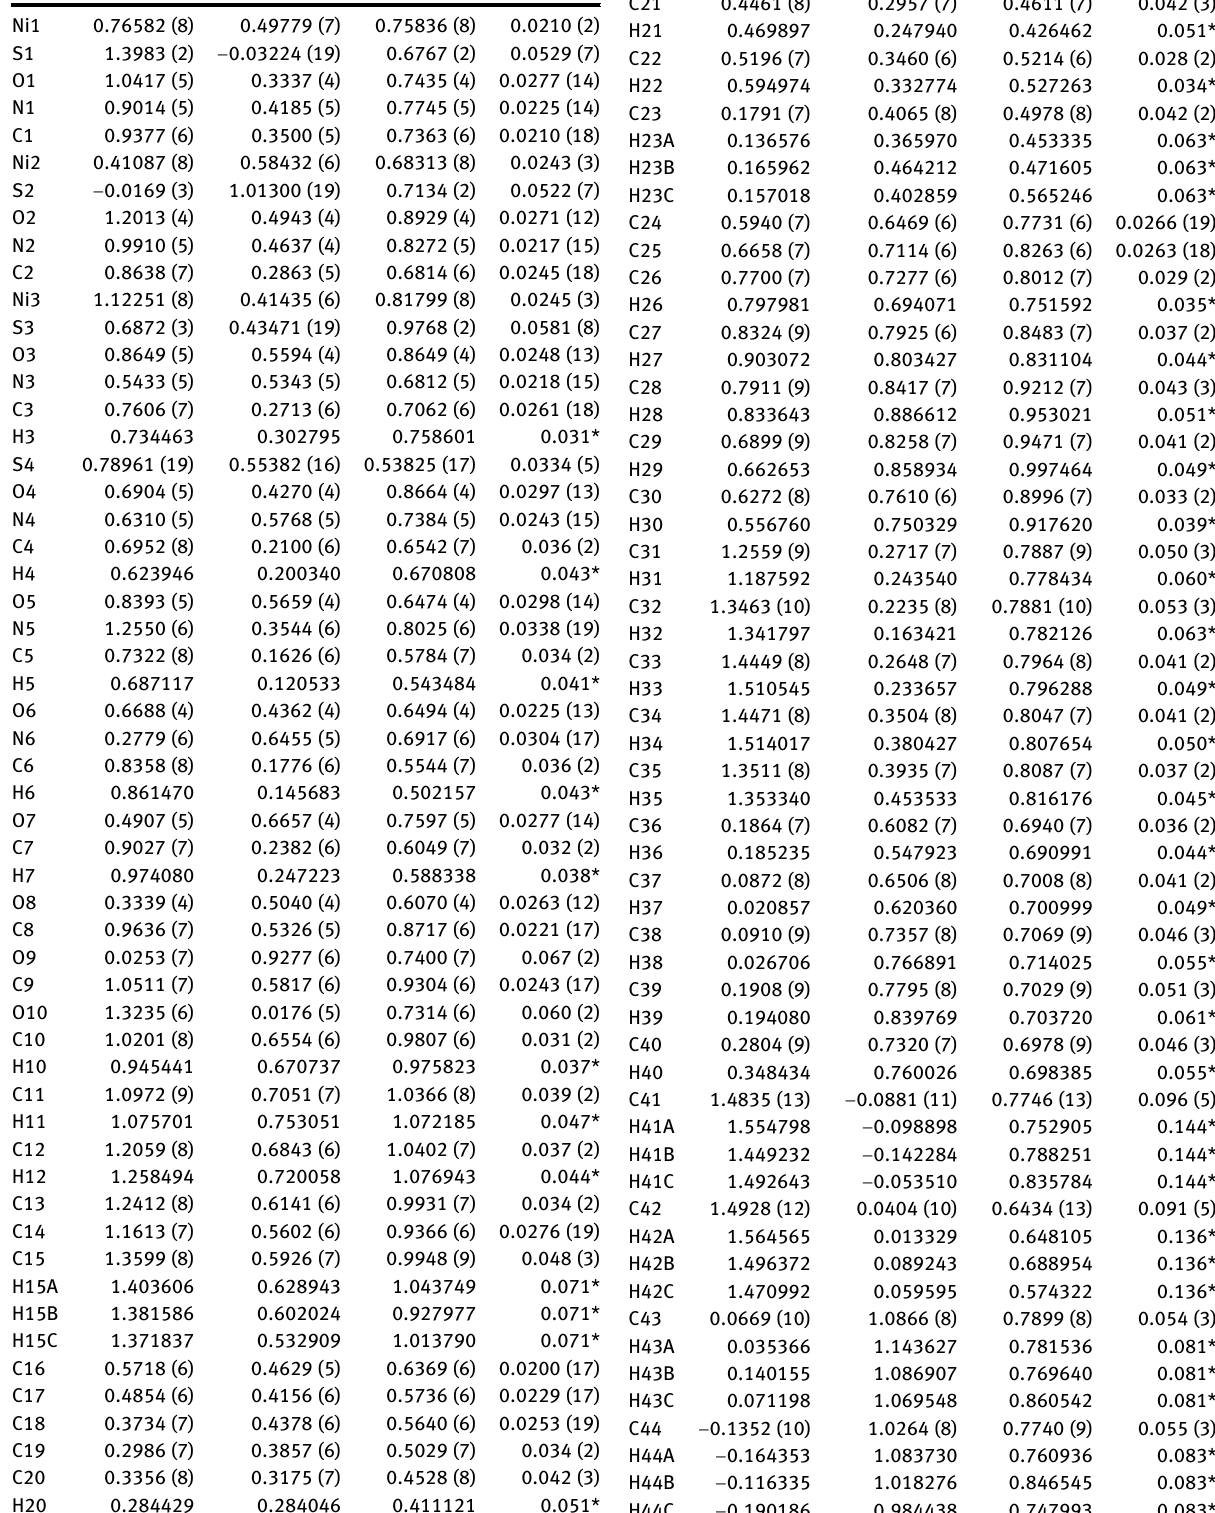
Table  : Fractional atomic coordinates and isotropic or equivalent isotropic displacement parameters (Å 